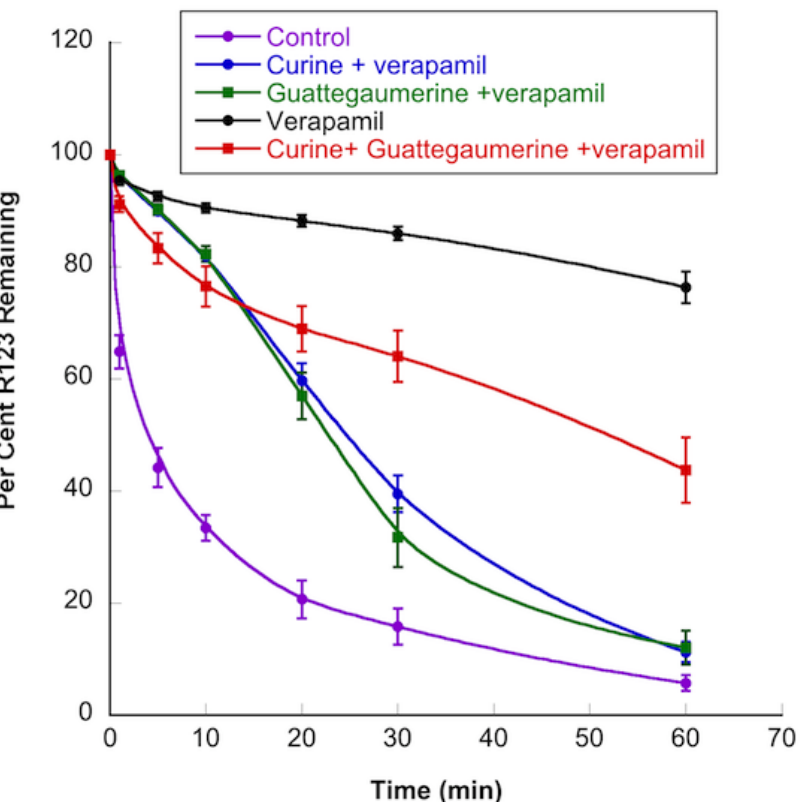
Figure 5. Effects of curine and guattegaumerine on the inhibition of rhodamine 123 efflux by verapamil. HTC-R cells were grown to confluence in DMEM and rhodamine accumulated for 90 min at 37 ◦ C. After washing the cells, the efflux of rhodamine was initiated at 37 ◦ C by the addition of PBS (control) or PBS containing verapamil, verapamil and curine, or verapamil and guattegaumerine at 100 µ M each. For the time indicated in abscissa, the amount of rhodamine output from cells was measured by fluorescence. The results are expressed as a percentage of rhodamine 123 remaining in the cells. They are representative of at least two independent experiments and show the mean ± SD of triplicate plates.